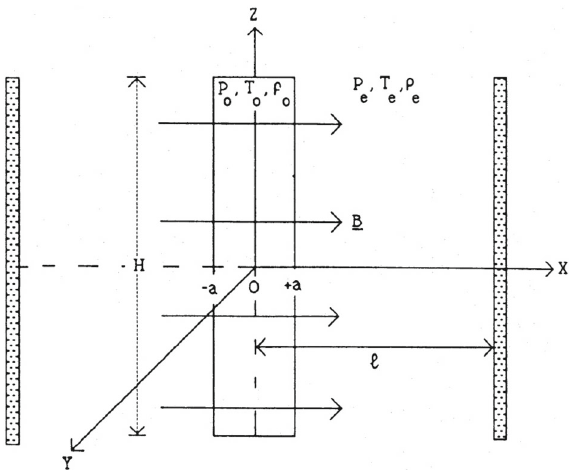
Fig. 37 Schematic diagram of a prominence slab in a coronal environment. The magnetic field is per- pendicular to the prominence axis and tied at the photosphere, represented by two rigid conducting walls at x = ± (cid:13) . Note that in the text the position of the photospheric walls is denoted by x = ± L . Image reproduced with permission from Joarder and Roberts (1992b), copyright by ESO